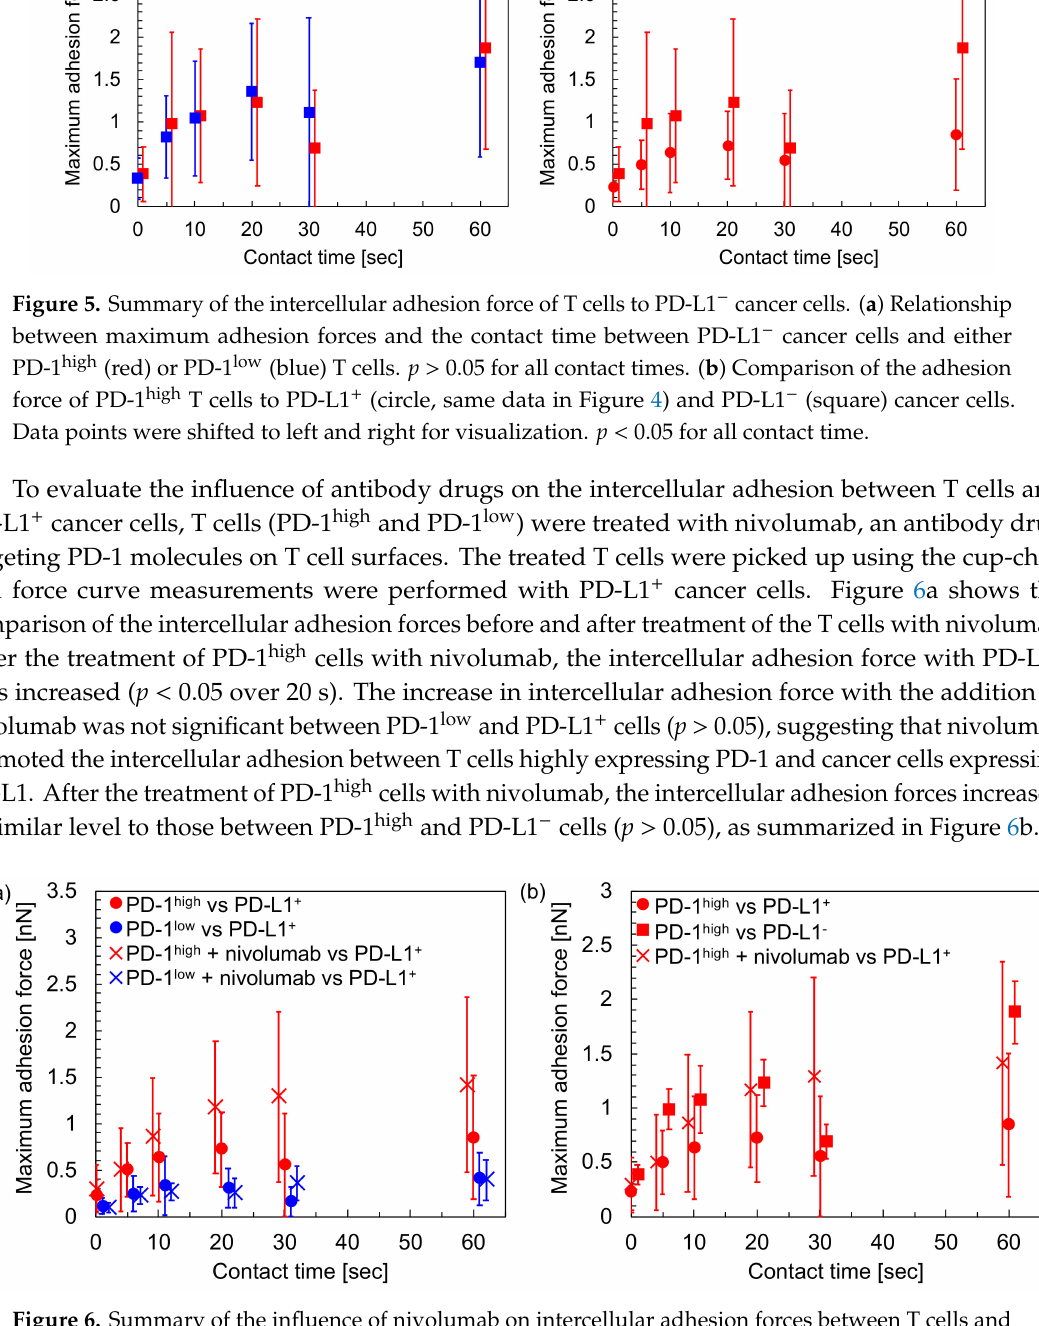
Figure 6. Summary of the influence of nivolumab on intercellular adhesion forces between T cells and cancer cells. ( a ) Comparison of the intercellular adhesion forces between T cells (either PD-1 high or PD-1 low ) and PD-L1 + cancer cells before (circle, same data in Figure 4) and after (cross) treatment with nivolumab. For PD-1 high vs. PD-L1 + before and after the treatment of nivolumab, p < 0.05 over 20 s contact time. ( b ) Comparison of the adhesion force of PD-1 high T cells to PD-L1 + (circle, Figure 4), PD-L1 − (square, Figure 5), and PD-L1 + cancer cells after treatment with nivolumab (cross). p > 0.05 between PD-L1 − (square) and PD-L1 + after treatment with nivolumab (cross) for all contact times. Data points were shifted to left and right for